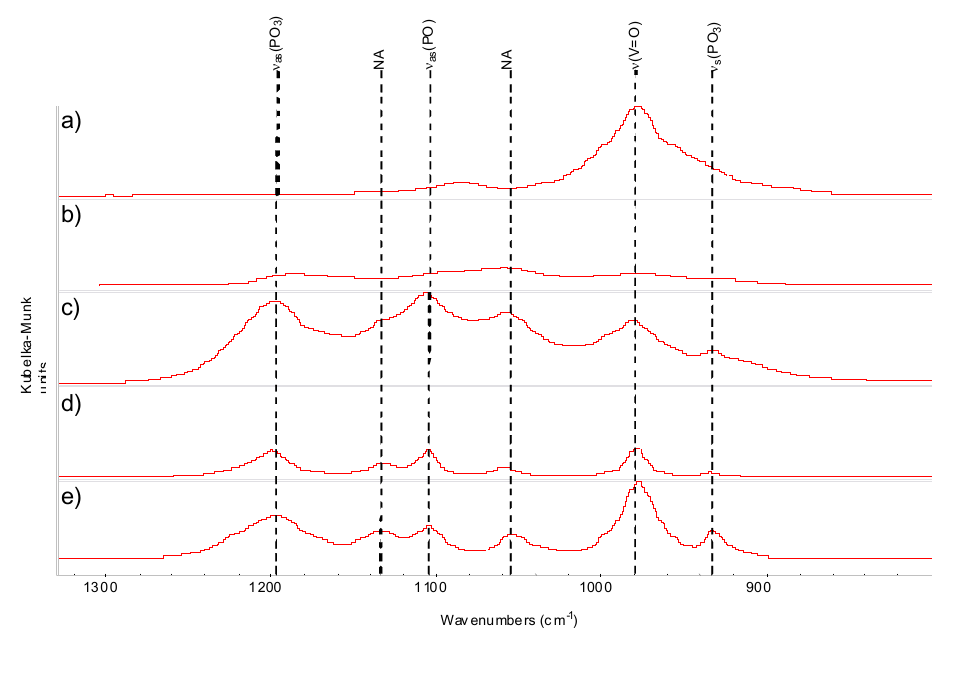
Figure 5. DRIFTS spectra of different VPO, (KM: Kubelka-Munk Units ( a ) Slurry dried on nitrogen; ( b ) High amount of solvent; ( c ) Medium amount of solvent; ( d ) Low amount ·0.5H O. NA: Non-assigned of solvent; ( e ) VOHPO 4 2